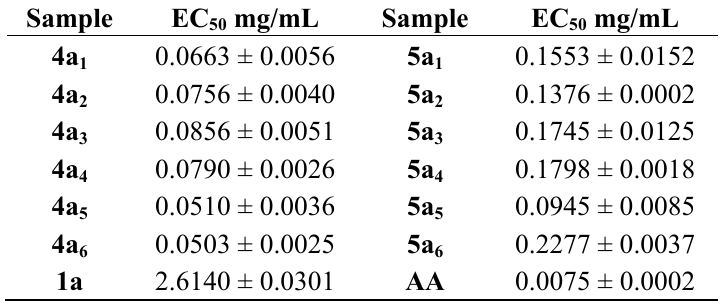
mg/mL) of the sulfadiazine derivatives 4a 50